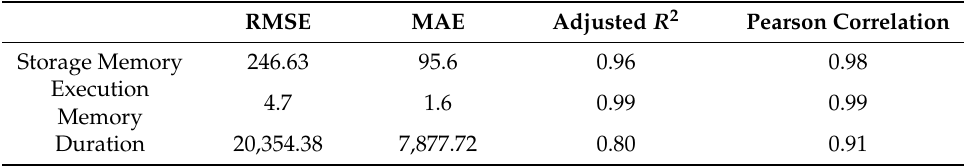
Table 7. Performance evaluation of the prediction